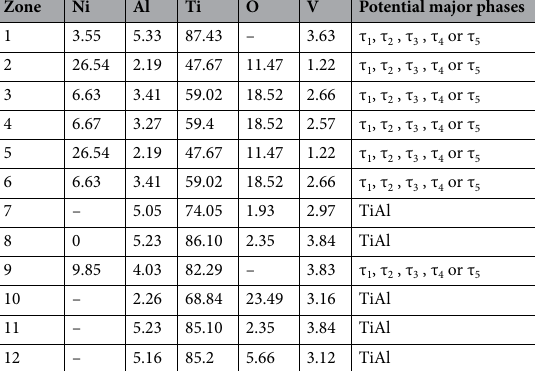
Table 2. Chemical composition (wt%) of points